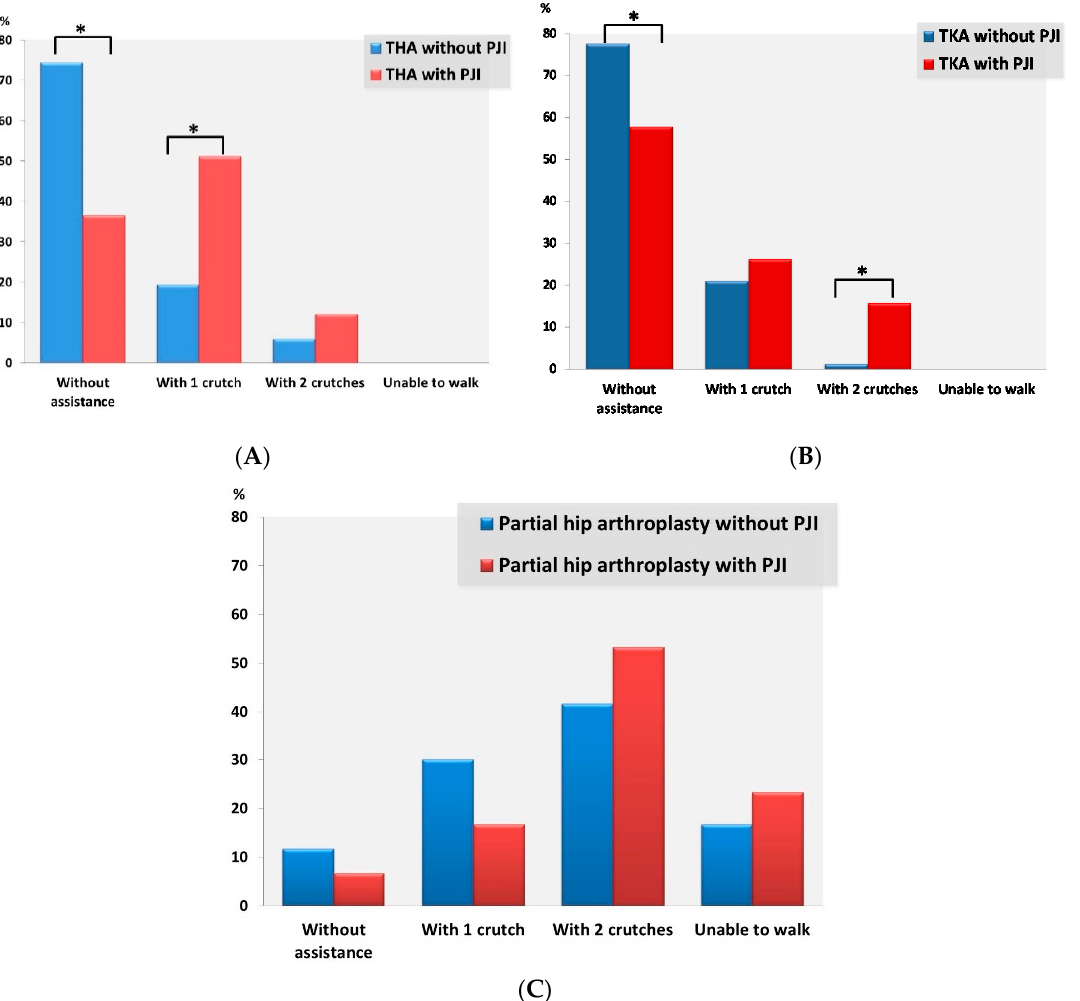
Figure 1. Functional ambulatory outcome in patients with total hip arthroplasty ( A ), patients with total knee arthroplasty ( B ), and patients with partial hip arthroplasty ( C ) with or without postoperative prosthetic joint infection. Total hip arthroplasty (THA), total knee arthroplasty (TKA) and PJI denote total hip arthroplasty, total knee arthroplasty and prosthetic joint infection, respectively. Statistically significant differences are marked with an asterisk (*).